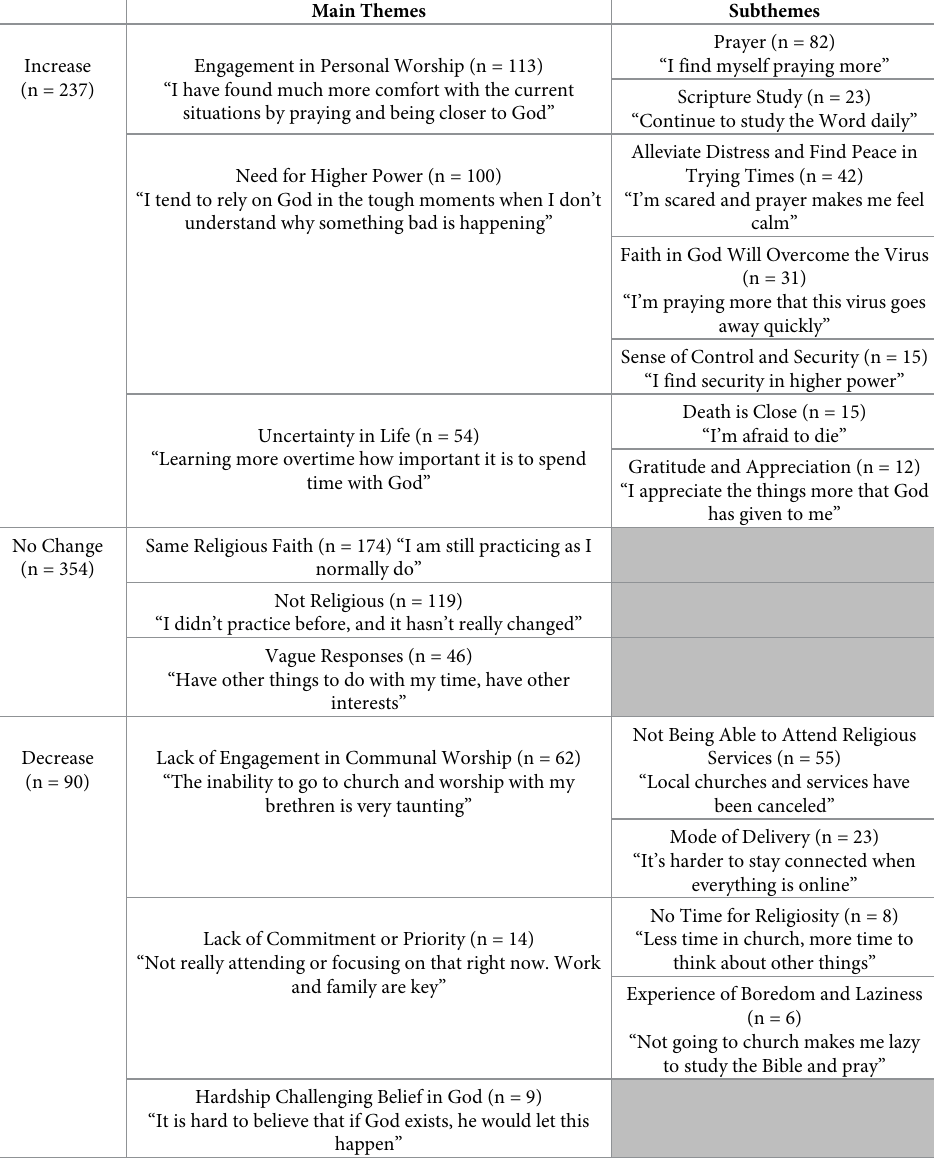
Table 3. Qualitative findings on why participants experienced changes in religious